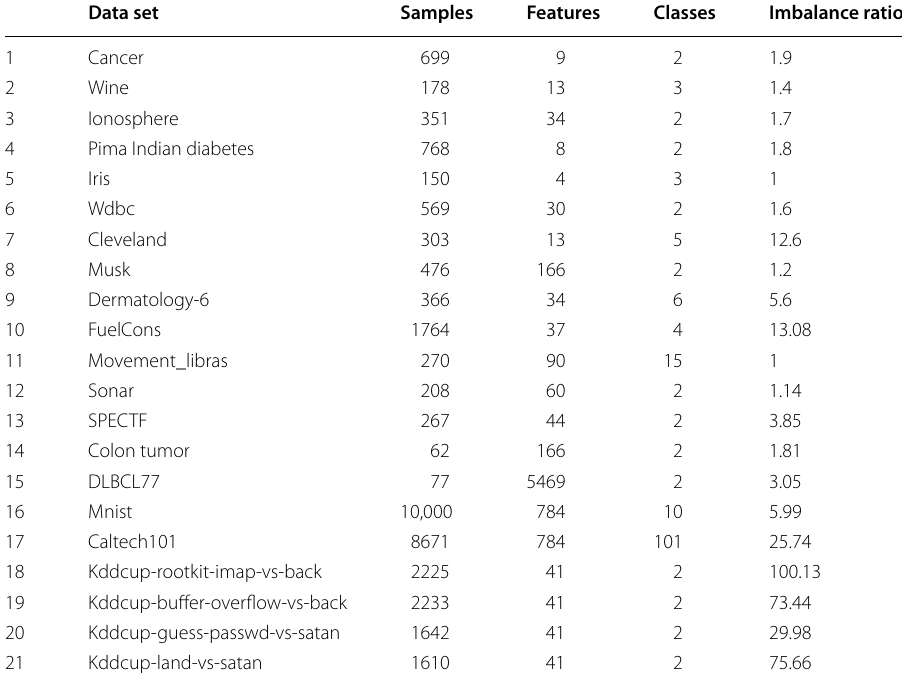
Table 2 Data sets used in experiments